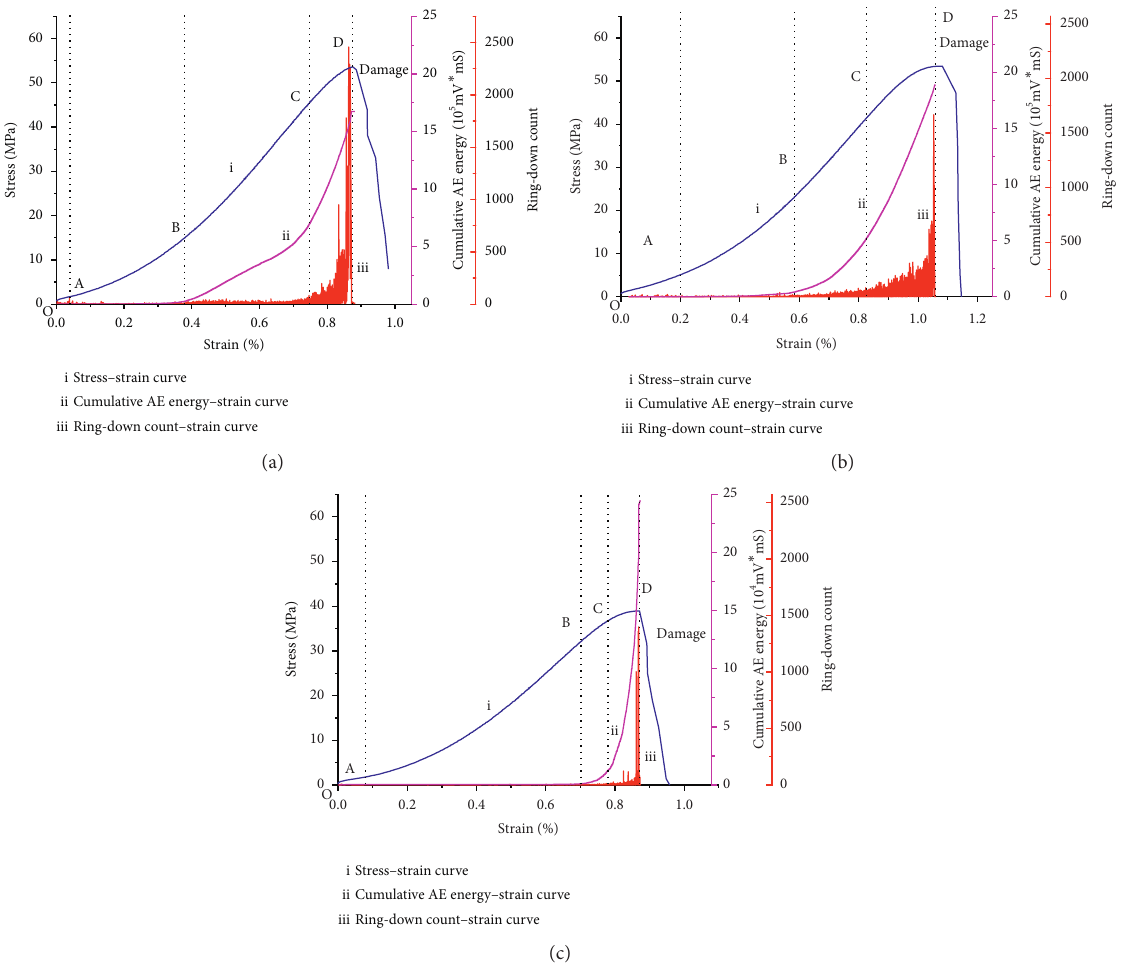
Figure 8: Stress-strain-cumulative energy-ring-down count curves of rock samples in different states. (a) Dry state. (b) Natural state. (c) Water-saturated